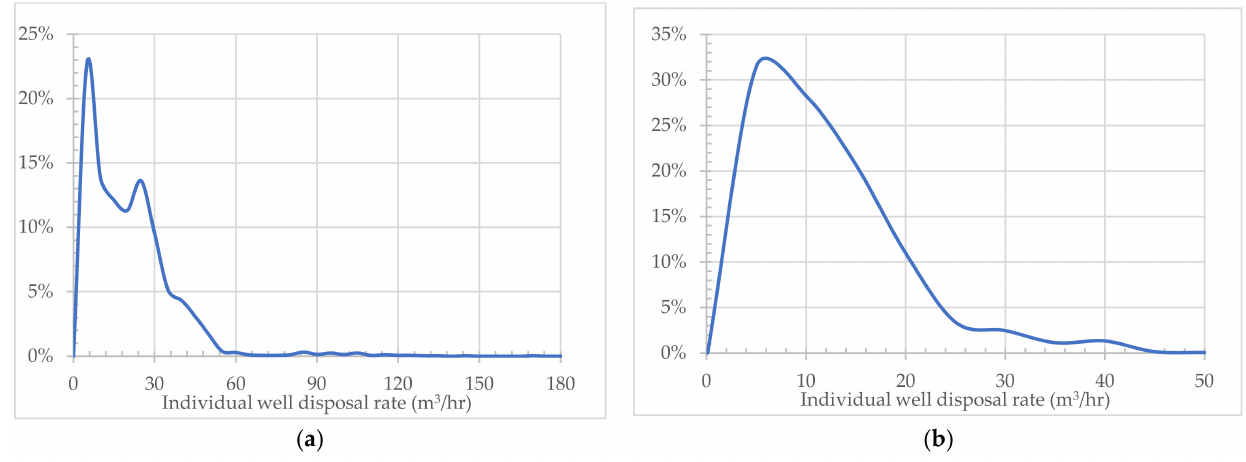
Figure A29. Historical per-well water injection rate ( X -axis) frequency ( Y -axis) distributions (January 1962–December 2022) in ( a ) the Cooking Lake Formation; ( b ) the Cairn Formation.